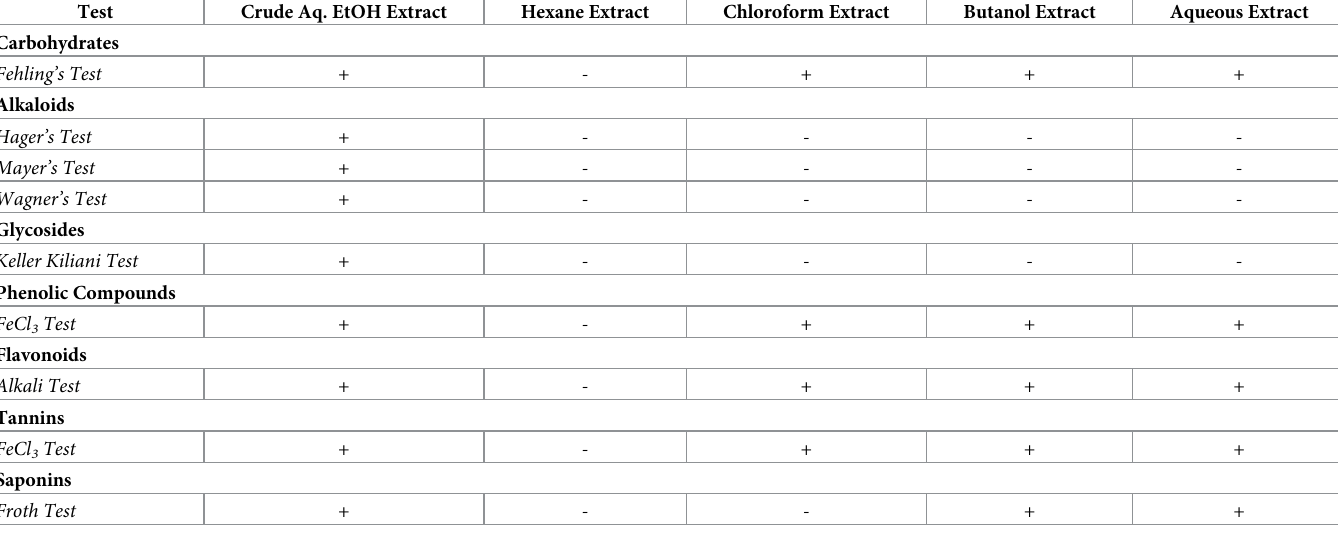
Table 1. Phytochemical evaluation of various extracts of Euphorbia nivulia Buch.-Ham.